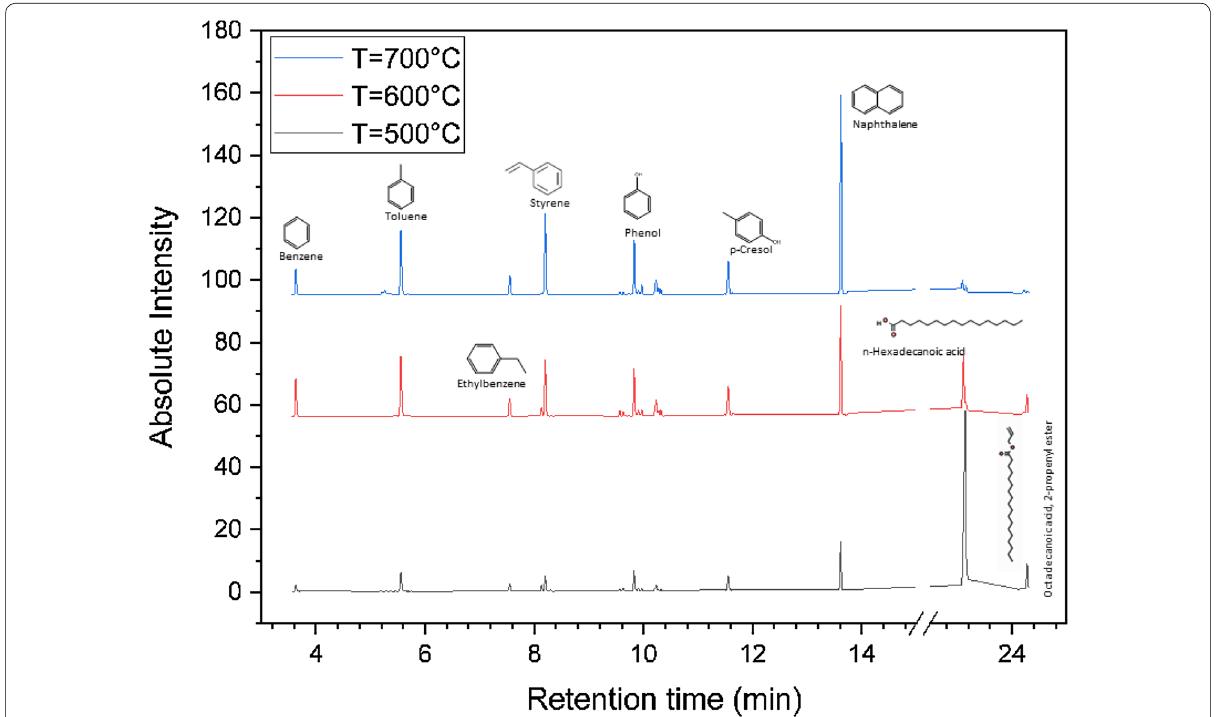
Fig. 4 GC–MS analysis of the bio-oil from SCG at reforming temperature of 500 °C, 600 °C and 700